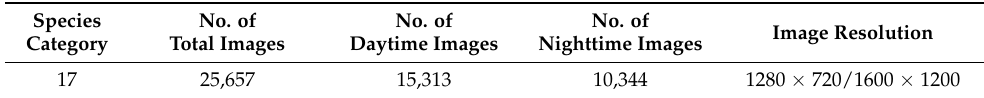
Table 2. The main properties of the NTLNP dataset.